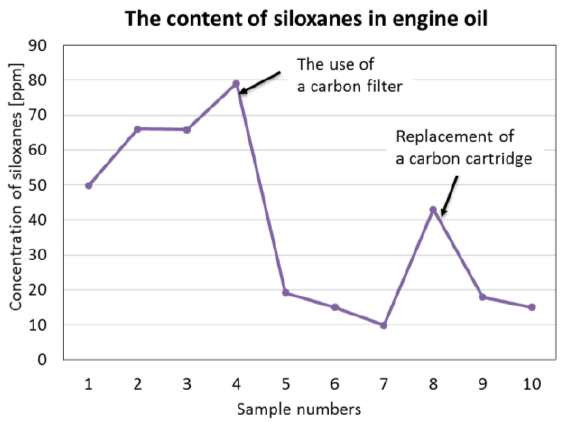
Fig. 7. Diagram presenting impact of activated carbon filter on siloxanes content in engine oil